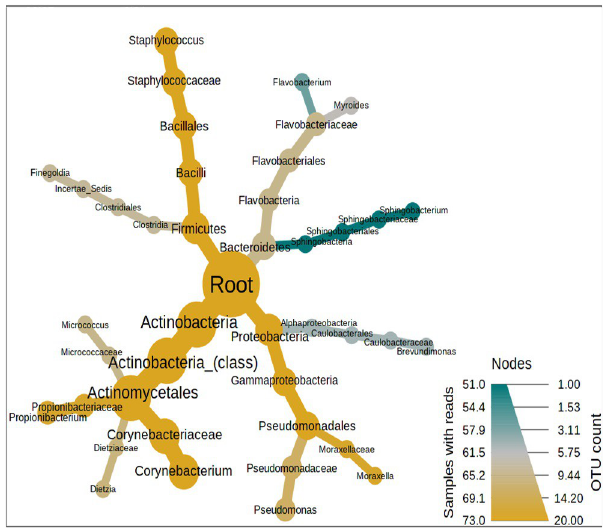
Fig 1. Taxonomic distribution of nasal bacterial population represented on a differential heat tree. The most common OTUs were picked by setting the parameters of minimum count as 10, sample prevalence as 50% and inter quartile range of 20%. The nodes in yellow represent the highly abundant taxa. The Wilcoxon rank test (P < 0.05) was applied on the median abundances of the chosen 20 OTUs.